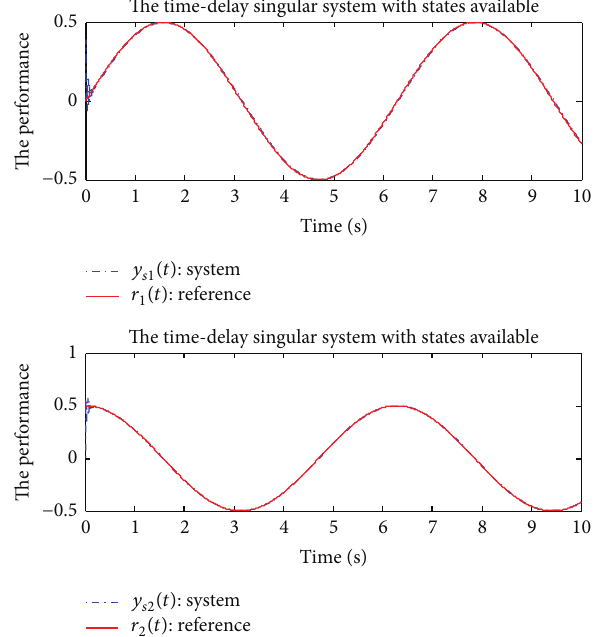
Figure 3: Output responses of time-delay singular system with states available by the new digital redesign approach.